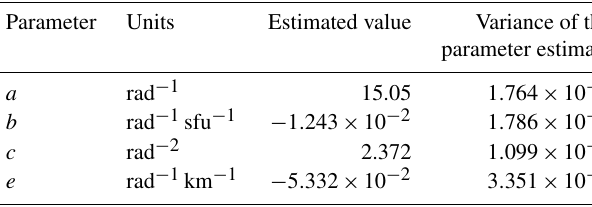
Table 6. Estimated model parameters and associated variances